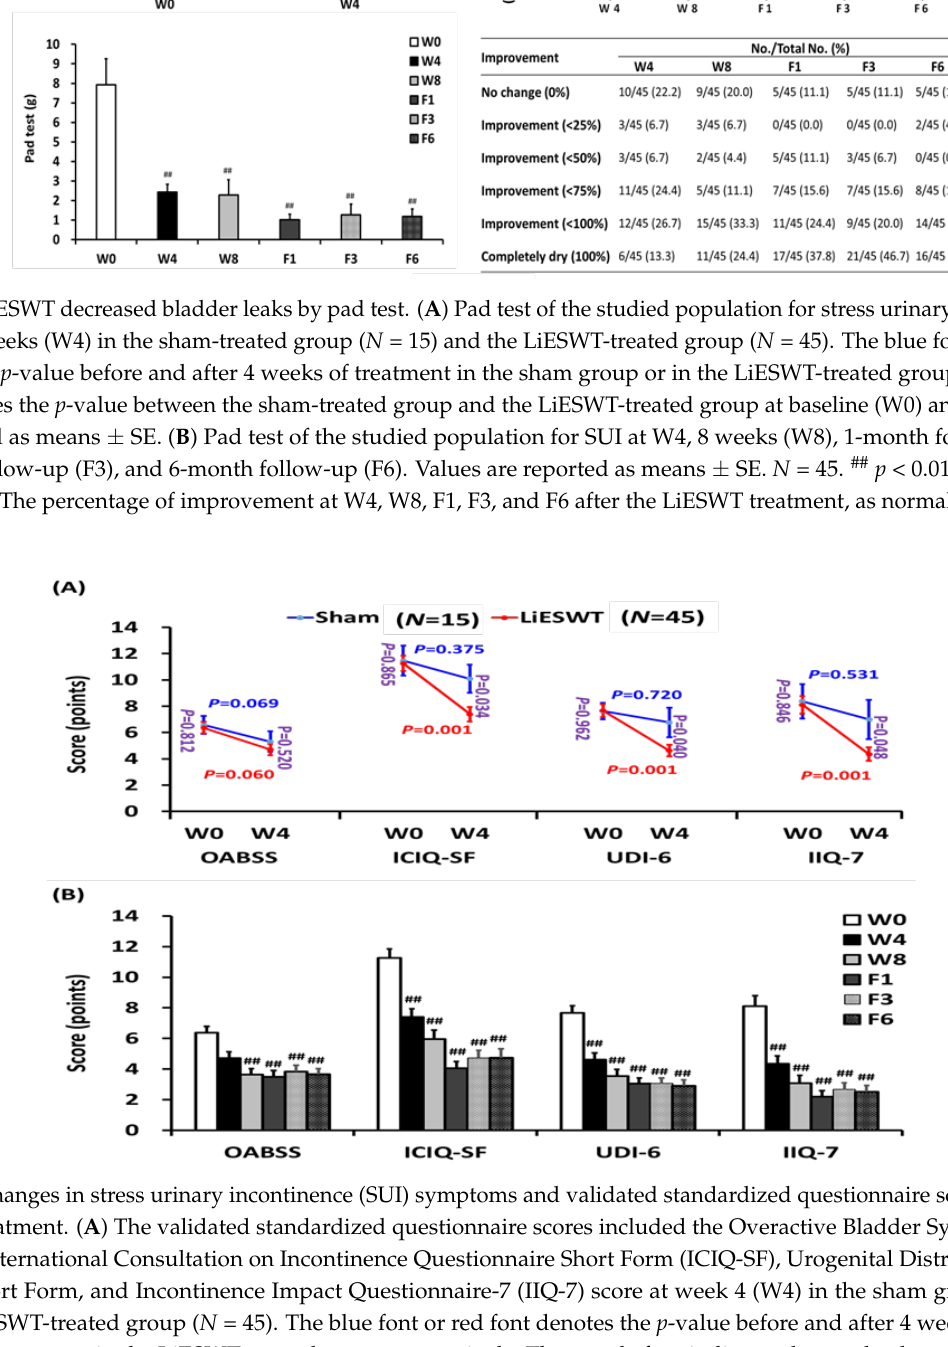
purple font indicates the p -value between the sham-treated group and the LiESWT-treated group at baseline (W0) and W4. Values are reported as means ± SE. ( B ) Pad test of the studied population for SUI at W4, 8 weeks (W8), 1-month follow-up (F1), 3-month follow-up (F3), and 6-month follow-up (F6). Values are reported as means ± SE. N = 45. ## p < 0.01 compared to the W0. ( C ) The percentage of improvement at W4, W8, F1, F3, and F6 after the LiESWT treatment, as nor- malized with the W0. N = 45.